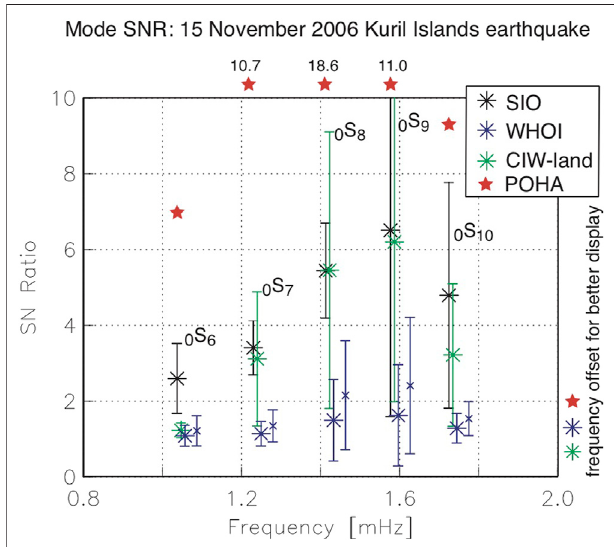
FIGURE 8 | Average of signal-to-noise ratios for different instrument types and fi ve low-frequency normal modes. Averages were determined over 7 SIO, 5 CIW-land and 17 WHOI instruments. The results are slightly offset in frequency between instrument types for better display. For reference, red stars mark the SNR measured at GSN station POHA. Blue ‘ x ’ mark a reanalysis of the seven best WHOI instruments.